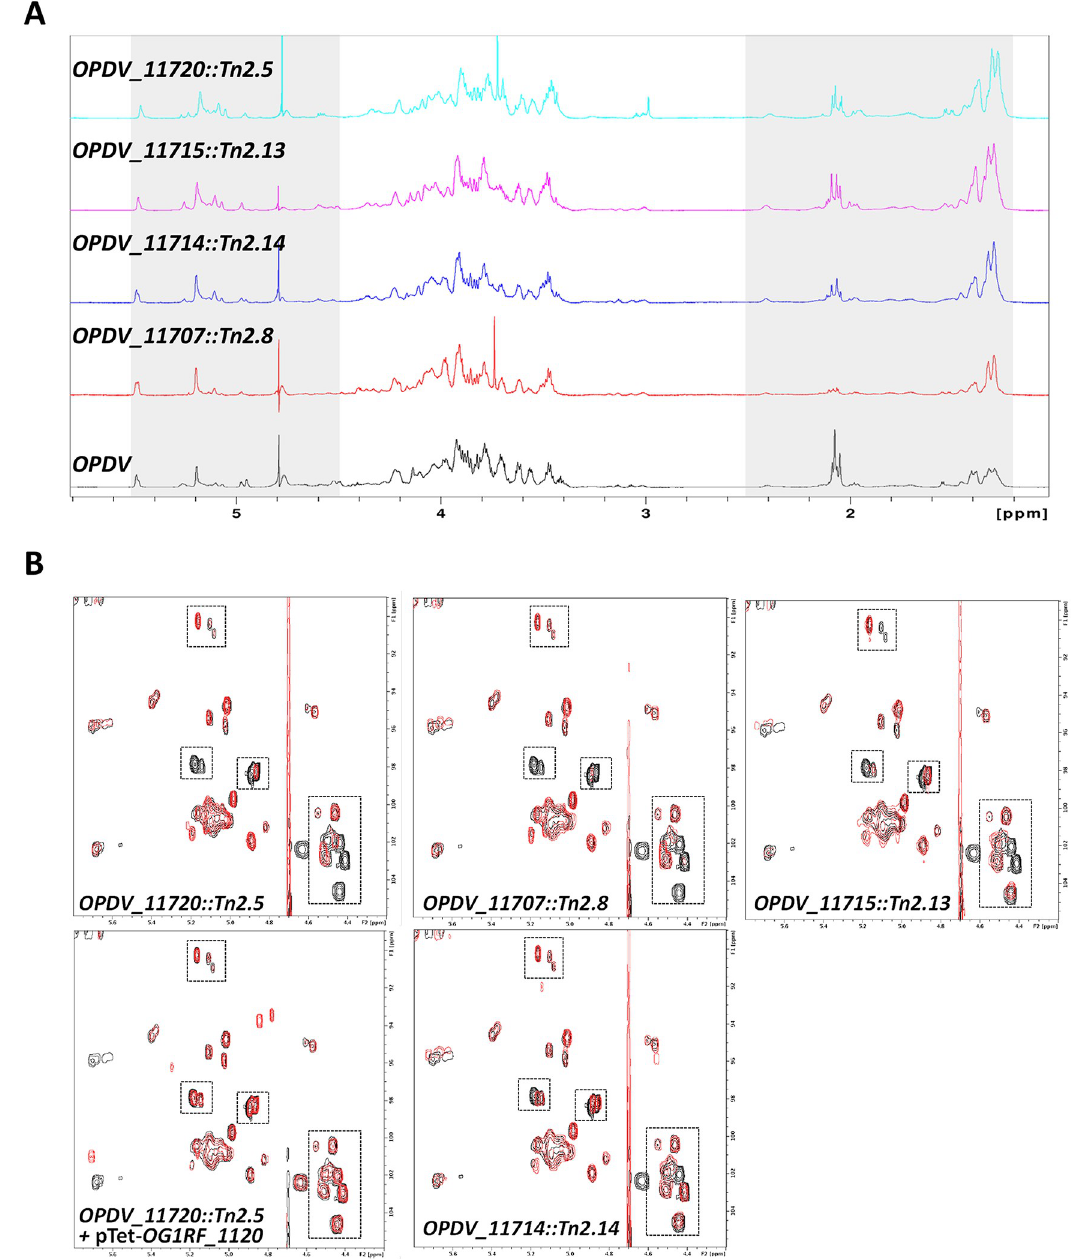
Fig 4. Structural analysis of purified EPA polysaccharides. A . 1D proton spectra of the EPA polysaccharides extracted from strains OPDV , OPDV_11720 :: Tn2 . 5 , OPDV_11715 :: Tn2 . 13 , OPDV_11714 :: Tn2 . 14 or OPDV_11707 :: Tn2 . 8 .The grey boxes indicate anomeric (4.5–5.5 ppm) and methyl protons (1.2–2.5 ppm). B . 2D 1 H- 13 C HSQC spectra of EPA polysaccharides. The region corresponding to anomeric protons (4.2–5.5 ppm) and anomeric carbons (90–105 ppm) is shown. OPDV signals are in black, mutant signals in red. Boxes show signals with a lower intensity or a shift in the mutant EPA samples. Close-up views of the boxed regions are shown in S4